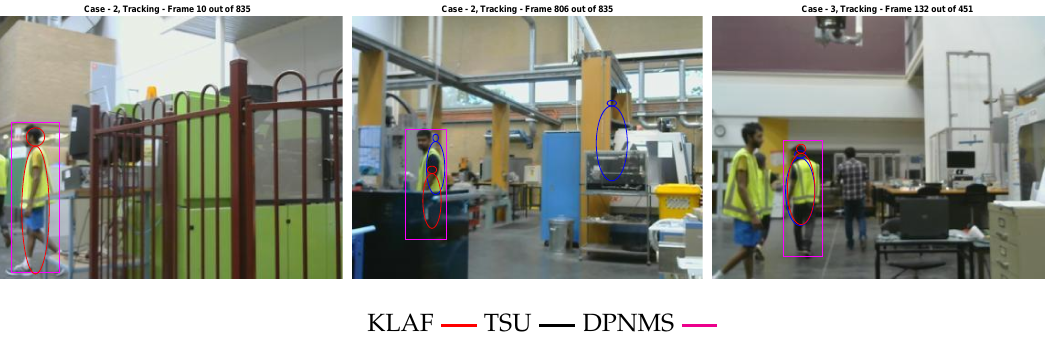
Figure 4. Instances where our methods have